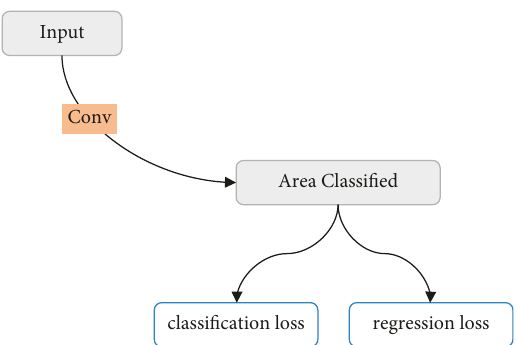
Figure 4: Single-stage class algorithm structure diagram.